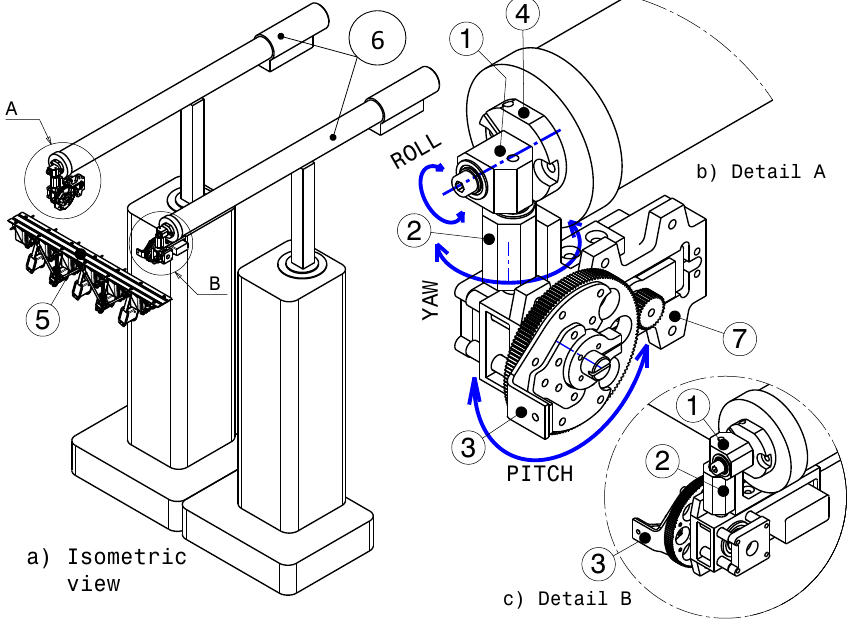
Figure 4. Final concept of the 6-DOF